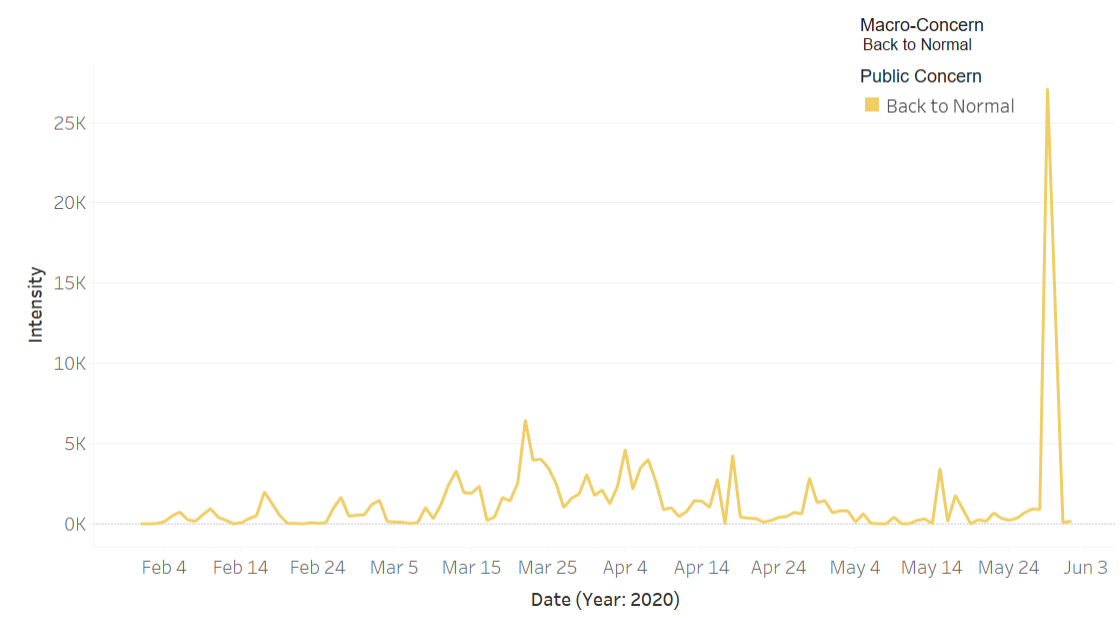
Figure 9. Daily Twitter activity for a public macro-concern (back to normal). This tweet was posted by the end of the nationwide coronavirus curfew. The Ministry of Health considered it the first stage to return to normal and started a new awareness campaign under the slogan “